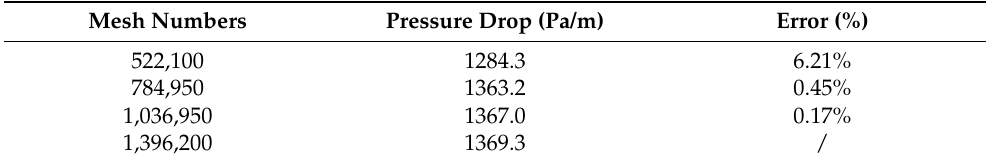
Table 2. Sensitivity of grid size to simulation results.